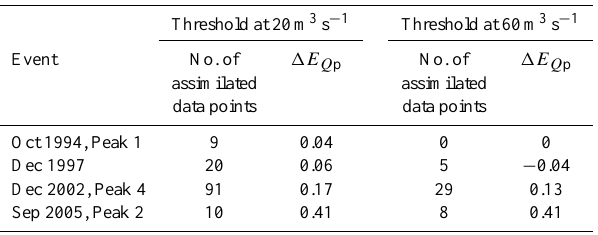
Table 3. Comparison of the number of assimilated data points and 1E Q p criteria for an observed discharge threshold set at either 20 or 60m 3 s − 1 .